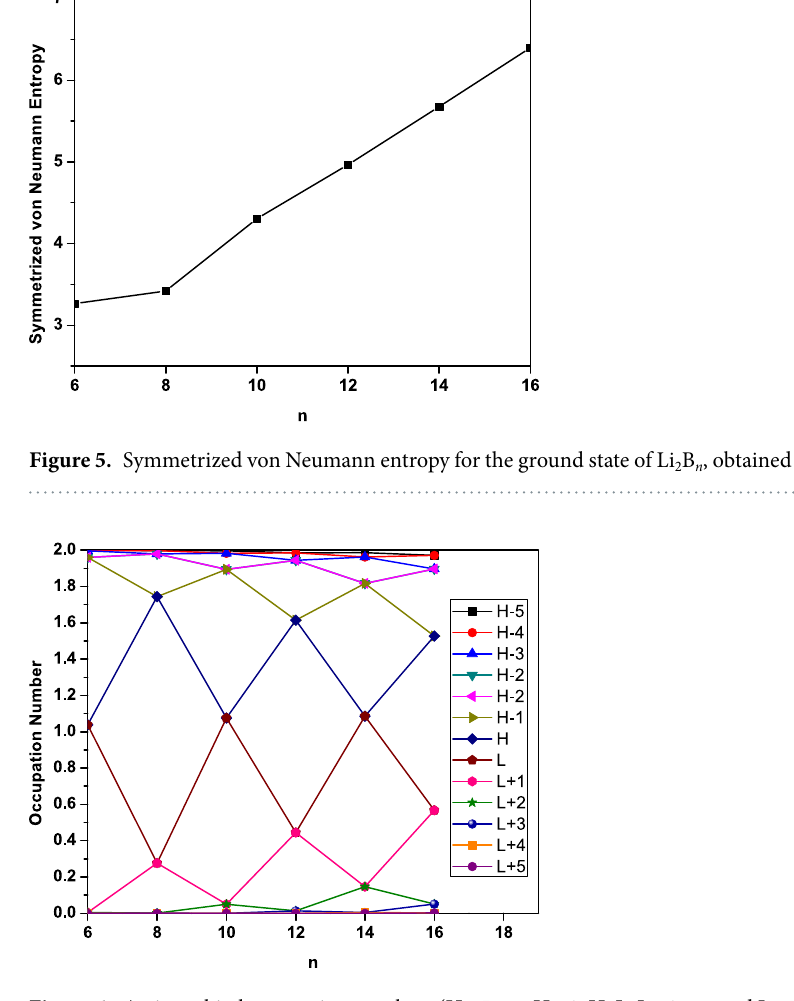
Figure 6. Active orbital occupation numbers (H − 5, … , H − 1, H, L, L + 1, … , and L + 5) for the ground state of Li 2 B n , obtained with TAO-BLYP-D. For brevity, HOMO and LUMO are denoted as H and L,